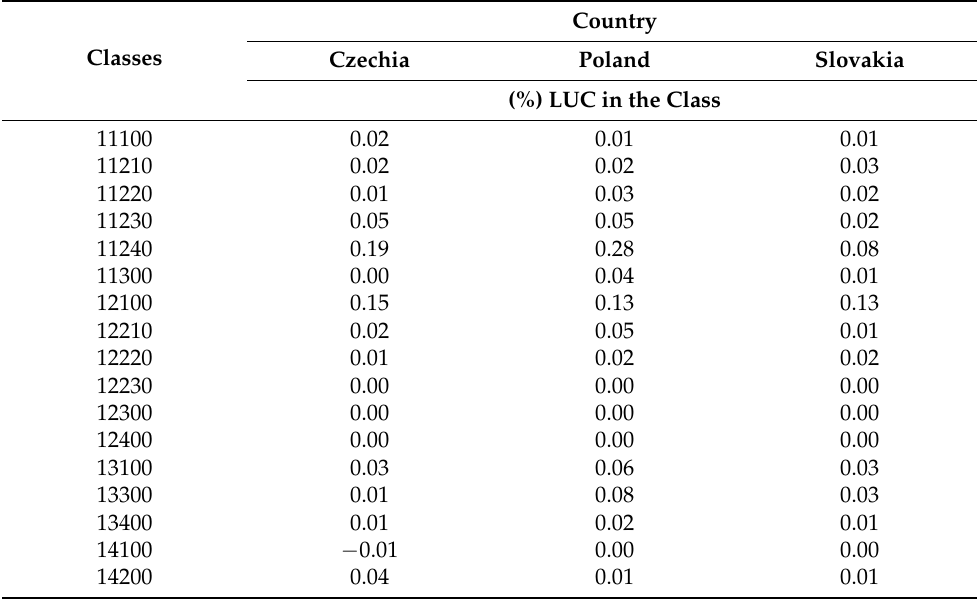
Figure 4. LUC in sub-classes of basic class 1—artificial surface between 2006 and 2012 in Czechia, Poland, and Slovakia. Table 2. Mean values of LUC in sub-classes of basic class 1—artificial surface between 2006 and 2012 in Czechia, Poland, and Slovakia.